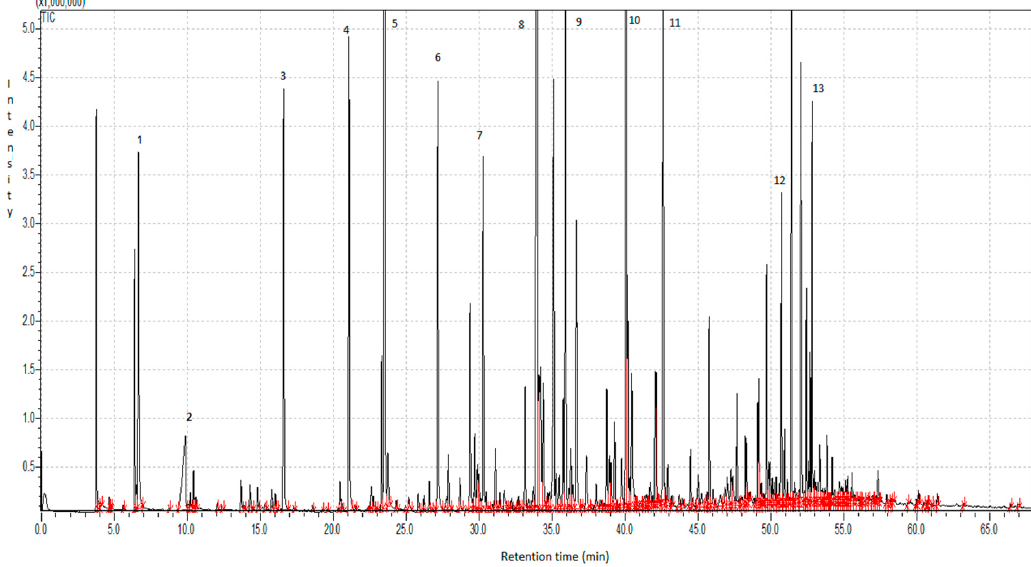
Figure 2. A typical gas ‐ chromatogram of PPSO indicating with numbers the most dominant volatile